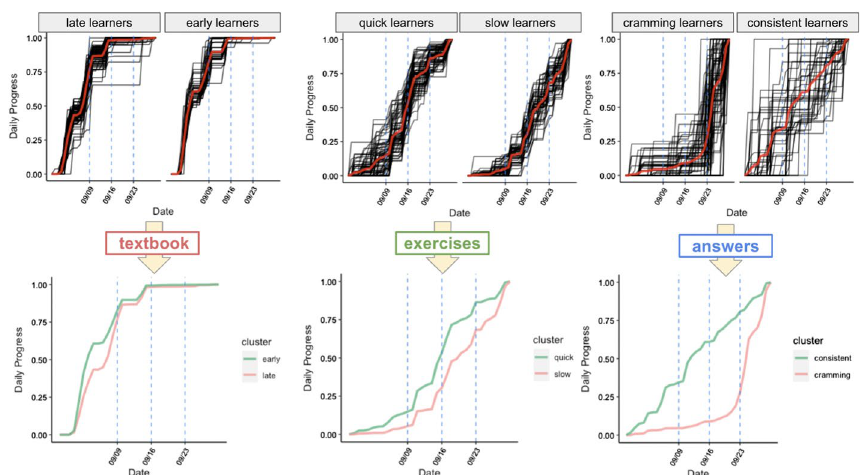
Fig. 7 Clusters of patterns of daily progress (DP)